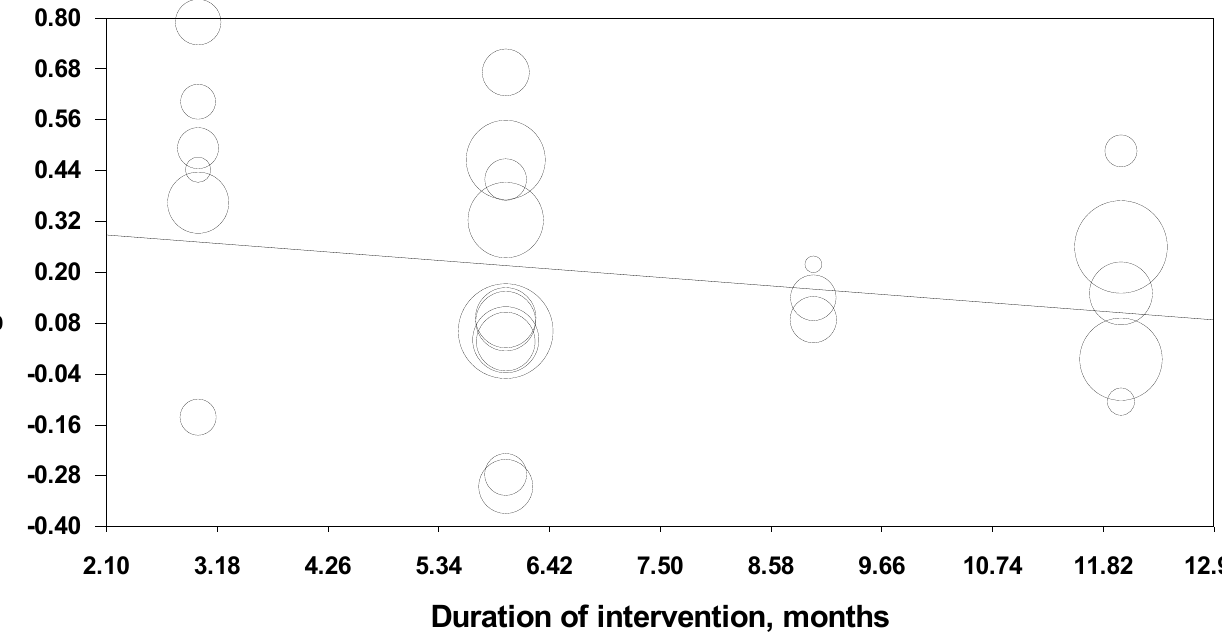
Figure A3. Note: point estimate of individual study ( ○ ); RBPM, remote blood pressure monitoring.